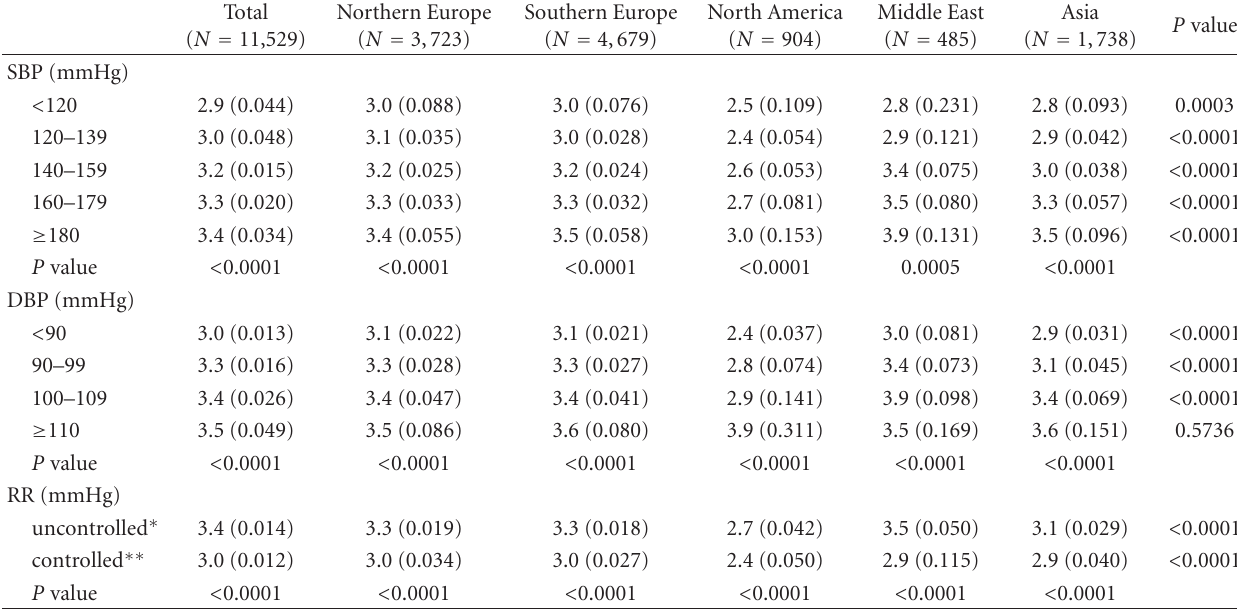
Table 6: Blood pressure and LDL-Cholesterol (mmol/L ± SD, adjusted for age, gender, and diabetes).